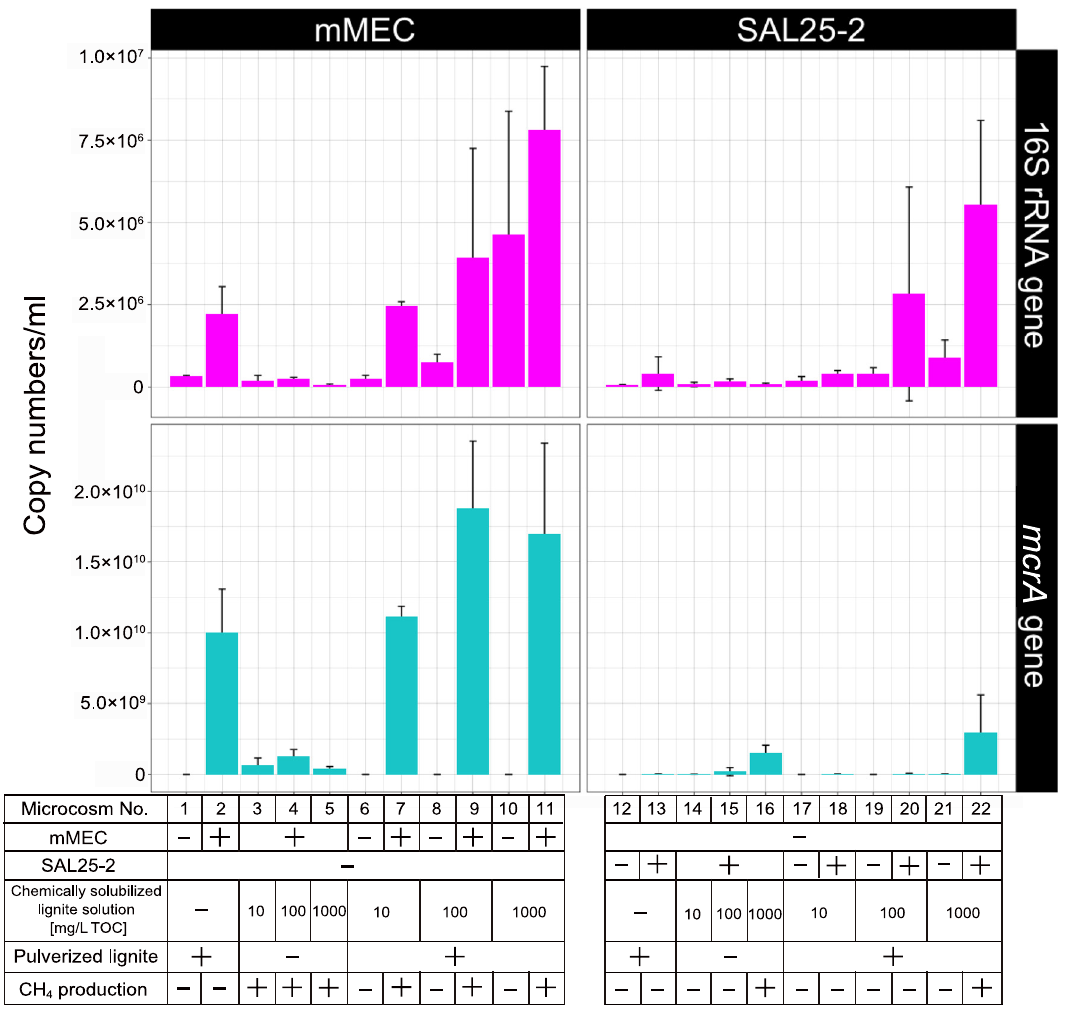
Figure 6. Copy numbers of 16S rRNA and mcrA genes in the microcosms using the mMEC (micro- cosms No. 1–11) and SAL25-2 (microcosms No. 12–22) determined by real-time qPCR. Bars represent mean value ± std. of triplicate samples. − , not added or absent; +, added or present.